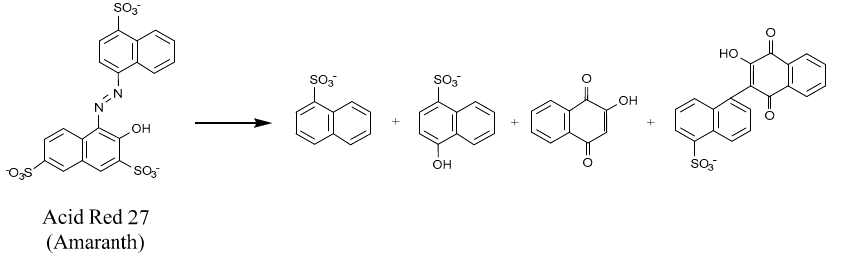
Figure 6. Three azo dyes (Acid Orange 7, Acid Orange 52, and Basic Orange 33) were used as the substrates in the first study about bleaching by Mn(III)